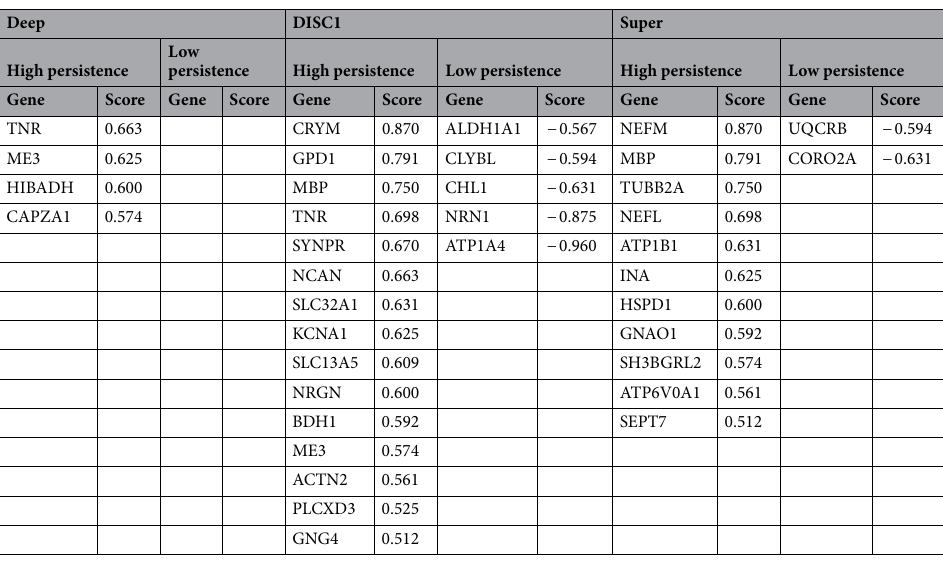
Table 1. “Persistent” genes in SCZ datasets. Genes that are significantly differentially expressed in SCZ vs CTL and have high (> 0.5) or low (< − 0.5) persistence